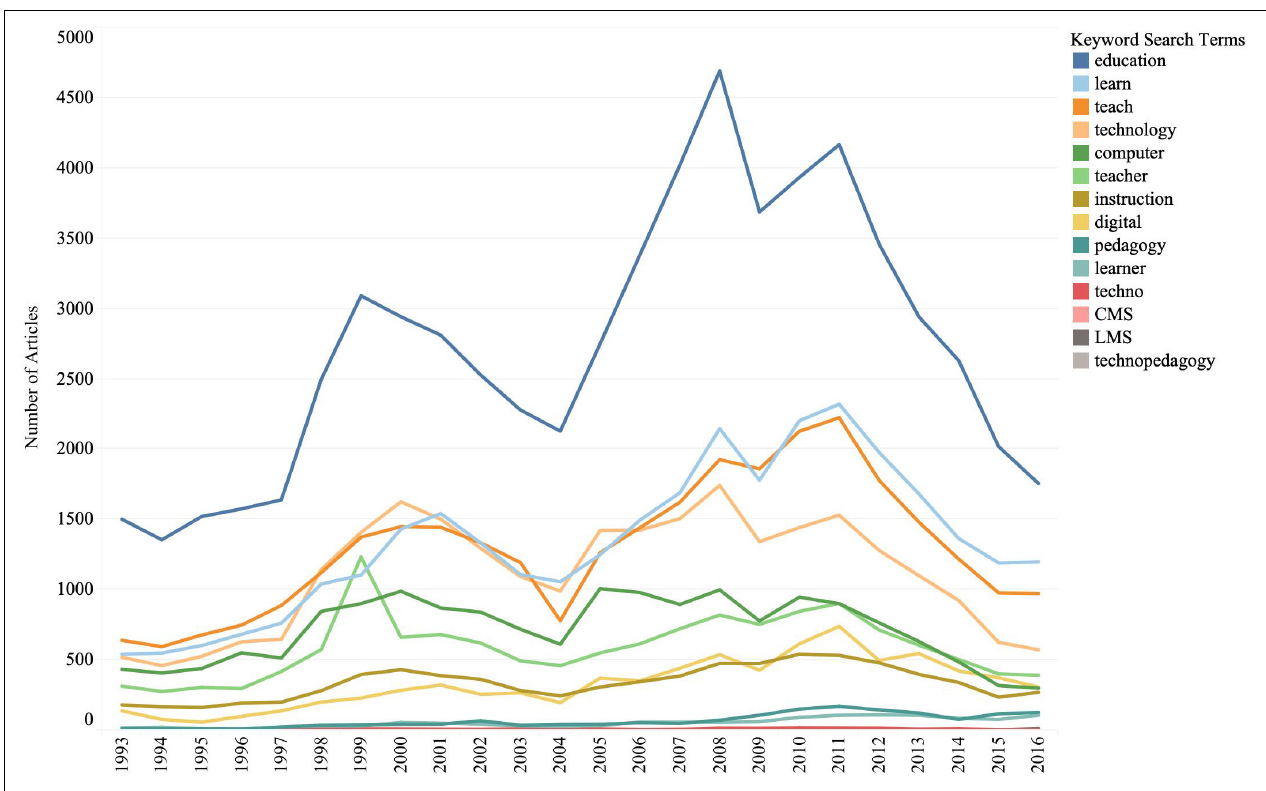
FIGURE 1 | The Chronicle of Higher Education Articles with Search Keywords, 1993–2016.